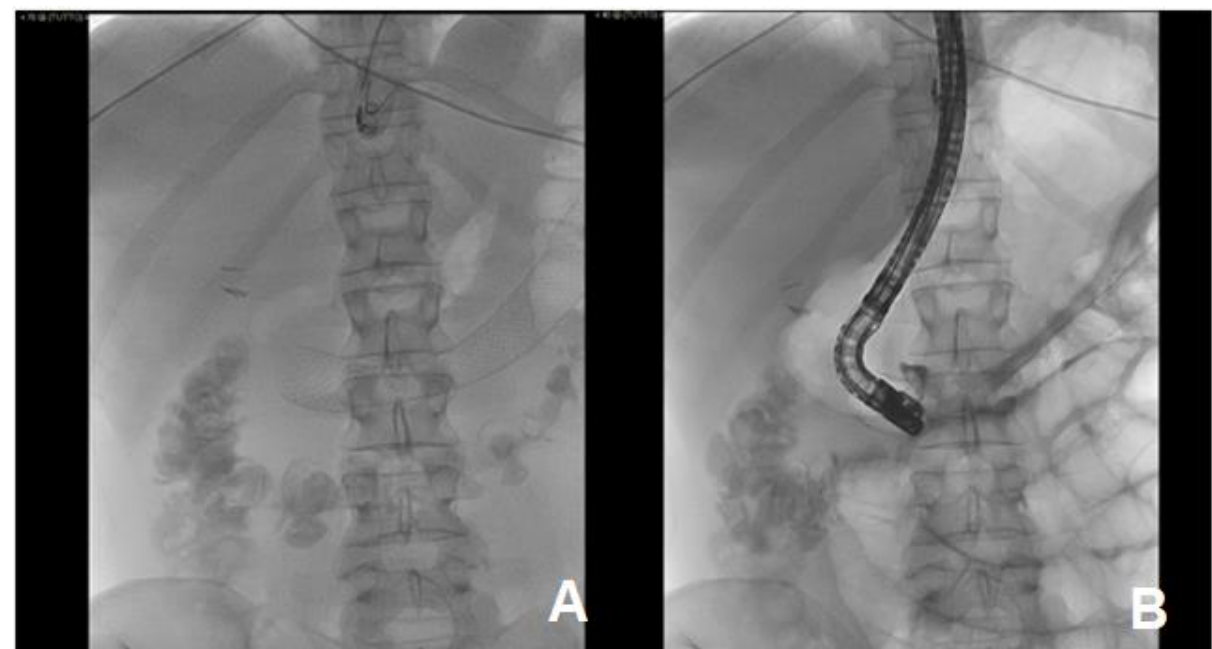
Figure 4. PTC (percutaneous transhepatic cholangiography). ( A ) On the left, imaging of the upper abdomen with evidence of a stent in duodenum; ( B ) on the right, the sphincterotome reaches the duodenal papilla, which appears impassable.